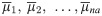
(A) The sub-JWNN structure and (B) the proposed FJWNN model structure.In this figure, where u1, u2, …, um are inputs, φ1, φ2, …, φn are the selected dominant wavelet neurons, W1,W2, …,Wn+m are weights of the sub-JWNN output layer, JWNN1, JWNN2, …, JWNNna are na sub-JWNN made from n dominant selected wavelets, η1,η2, …,ηna are outputs of the na sub-JWNN, v1,v2,…, vna are na weights of fuzzy rules, μ-1,μ-2,…,μ-na are the membership function values of each rule in FJWNN modeling, and PH is the prediction horizon.